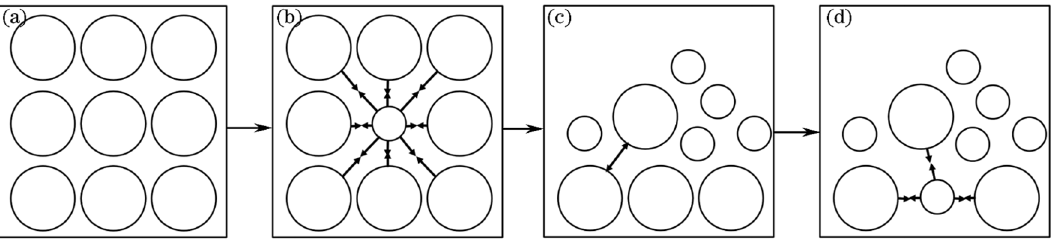
Figure 4. Evolution diagram of cementation of compound soil particles.